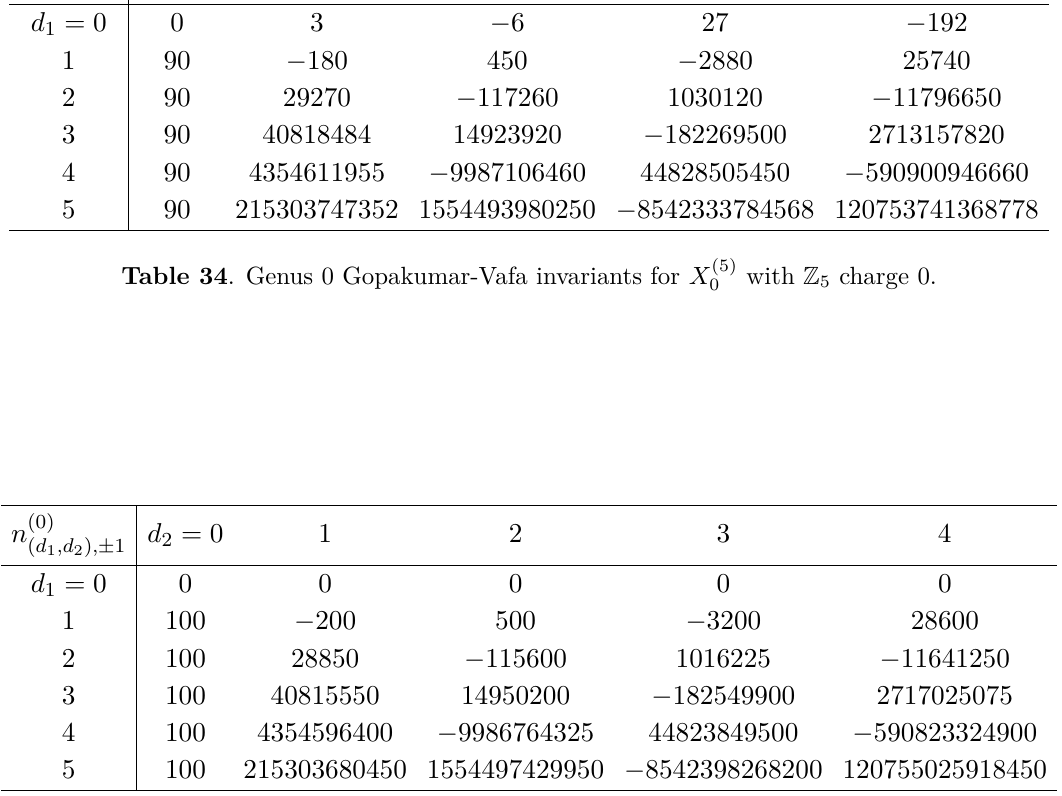
Table 35 . Genus 0 Gopakumar-Vafa invariants for X (5)